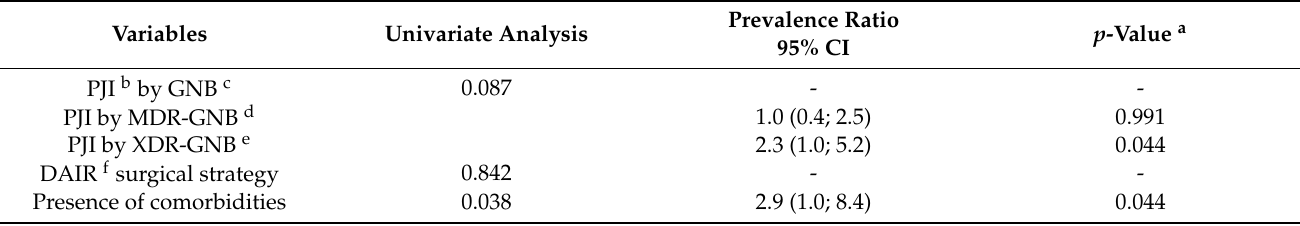
Table A3. Evaluation of the influence of variables of interest on the time to therapeutic failure–univariate and multivari- ate